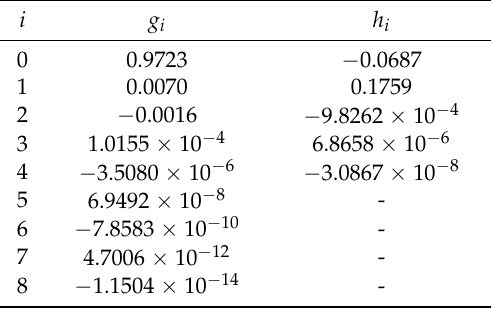
Table 4. The coefficients of polynomials for Equations (12) and (13). (cid:2191) (cid:2189) (cid:2191)